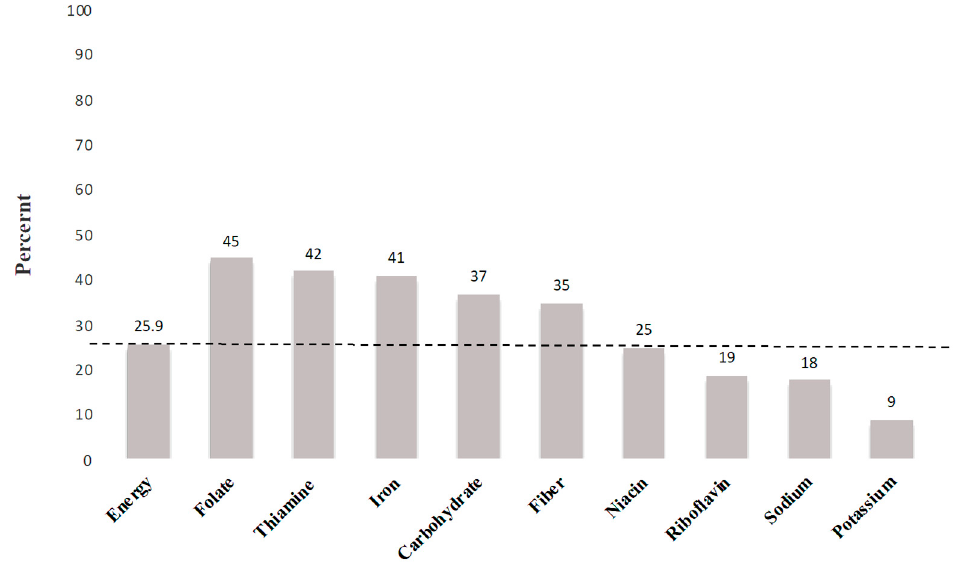
Figure 1. Energy and nutrients from all grain foods in the daily diet of Canadains aged two years old and above. The dashed line represents the percentage of energy provided and identifies nutrients that surpass energy contribution.